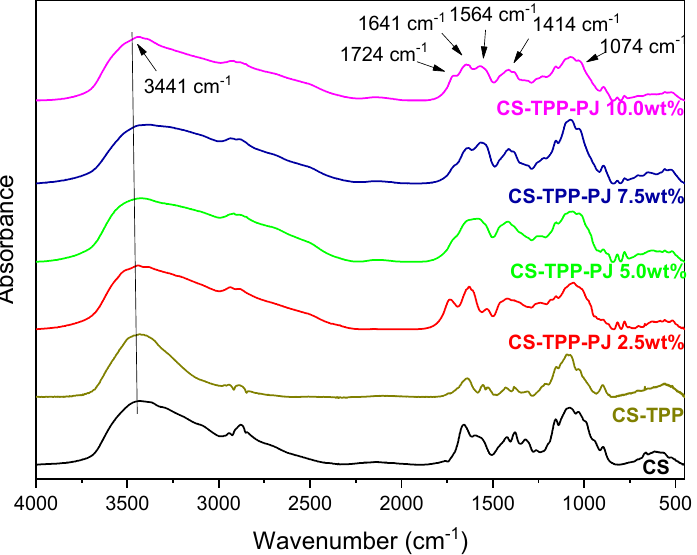
Figure 6. FTIR spectra of CS nanoparticles 2.5, 5.0, 7.5 and 10.0 wt% containing PJ.